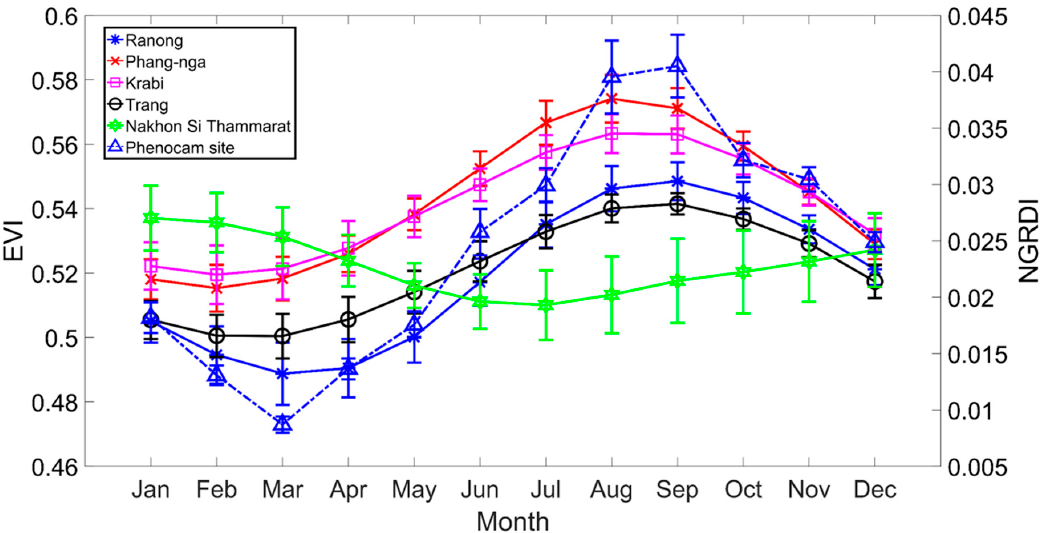
Figure 4. Phenology profiles from MODIS and phenocam images. EVI profiles of mangroves at five local sites of Southern Thailand averaged across 13 years. The Nakhon Si Thammarat site located at the Gulf of Thailand has a different EVI than the other sites in both amplitude and phase. The Normalized Green-Red Di ff erence Index (NGRDI) profile of the phenocam site (Phuket province) averaged over March 2015 to August 2016.